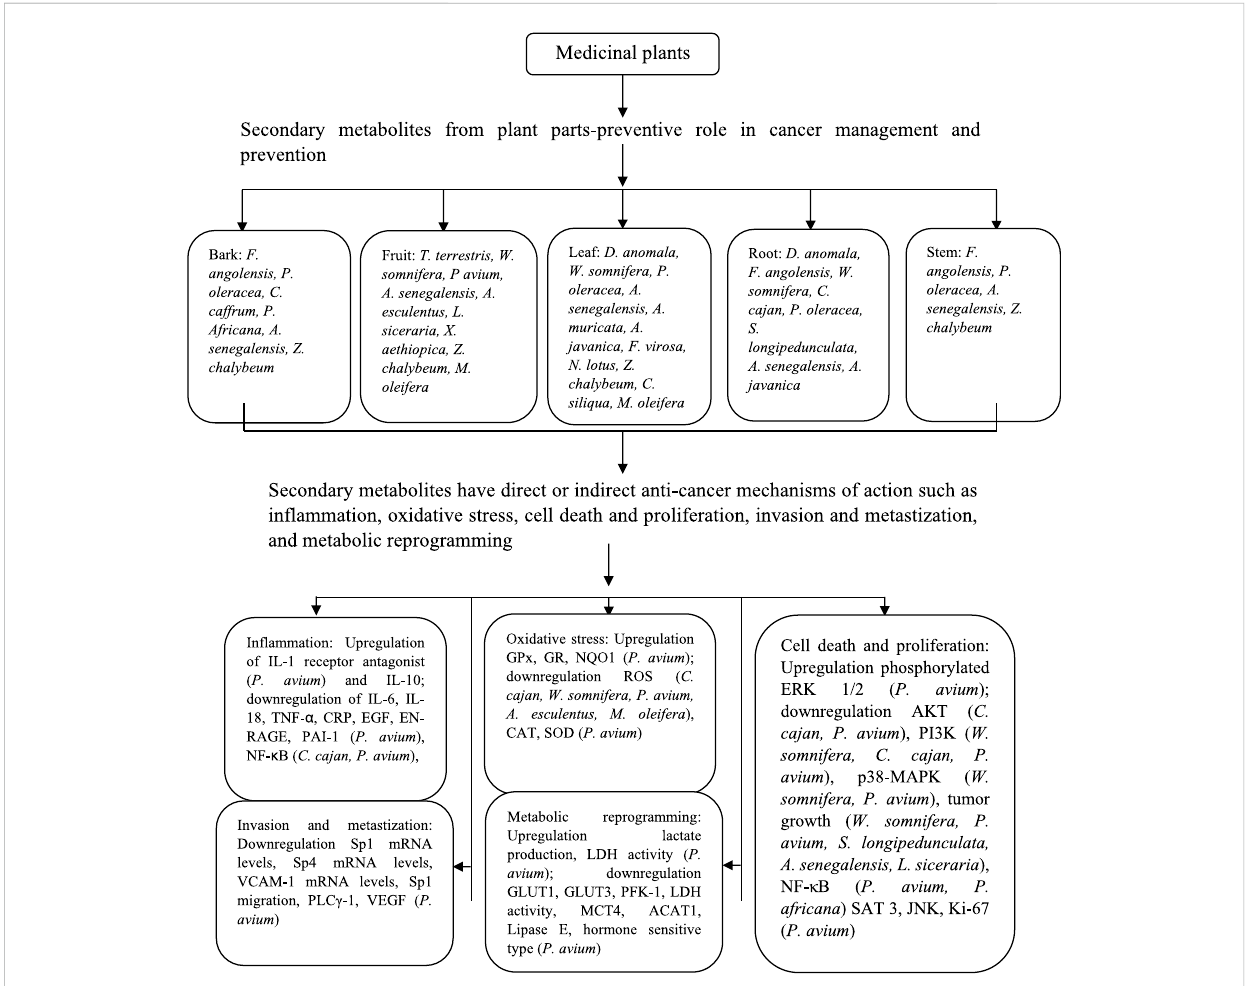
FIGURE 2 Diagrammatic depiction of medicinal plant parts involved in therapeutic effects against various types of cancers and their target pathways.